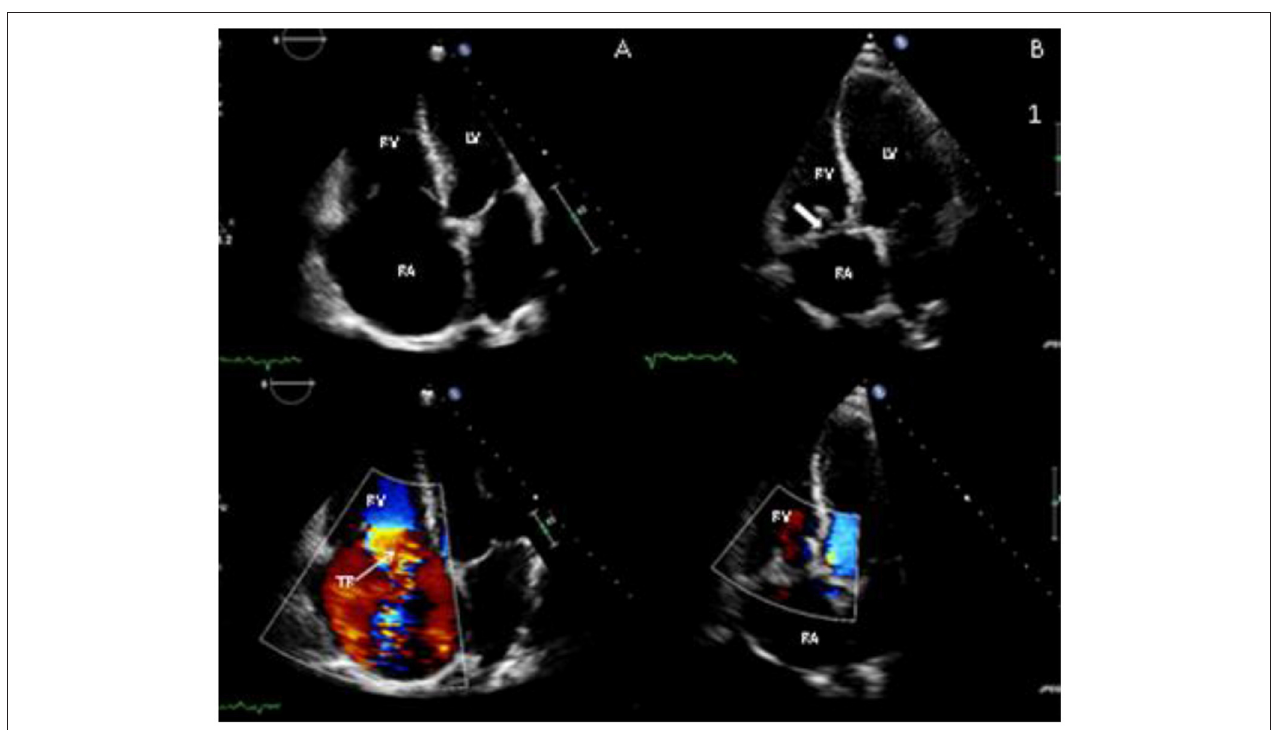
FIGURE 3 | Transthoracic echocardiography images before surgery (A) and after surgery (B) showing apical 4-chamber view of the tricuspid valve (TV). In the pre-surgery images there is failure of leaflet co-aption (note closed position of mitral valve) due to valve degeneration, with severe tricuspid regurgitation (TR) on colour Doppler (lower panels); post-surgery, the right ventricle (RV) and right atrium (RA) have reduced in size and there is a tricuspid valve bioprosthesis (thick arrow) in situ , with resolution of TR.